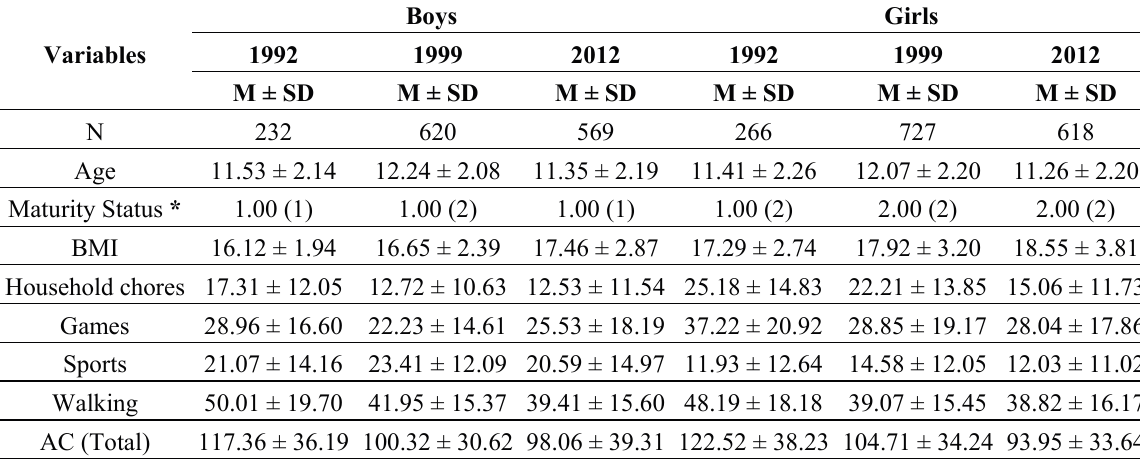
Table 1. Descriptive statistics by gender and